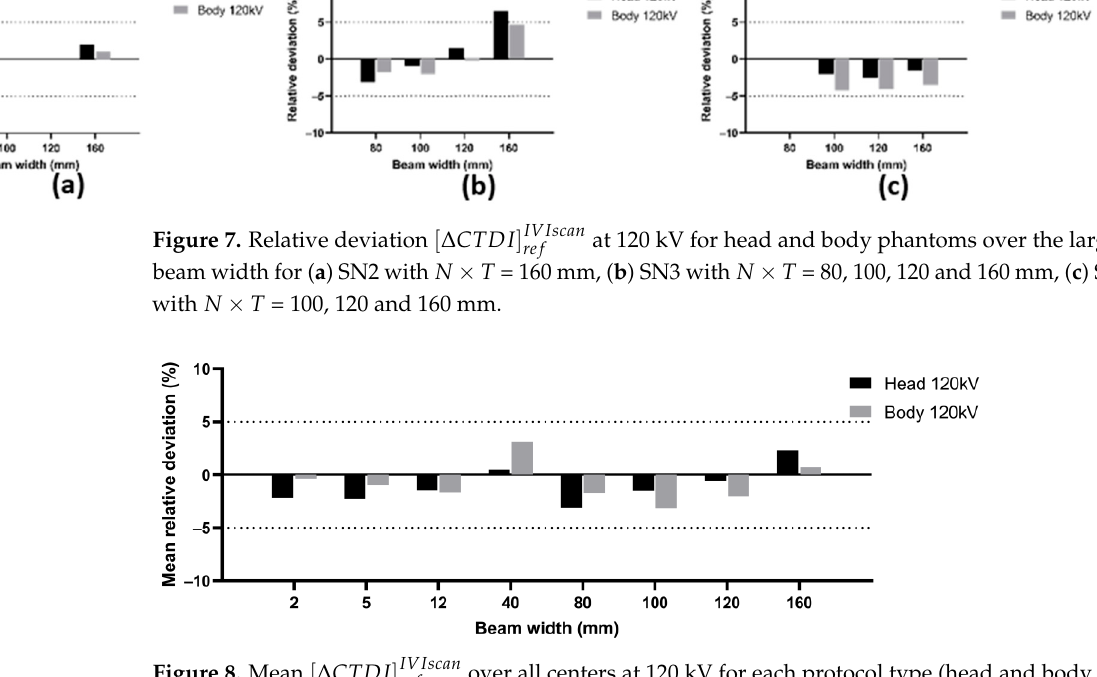
Figure 8. Mean [ ∆ CTDI ] IVIscan over all centers at 120 kV for each protocol type (head and body and Figure 8. Mean [∆𝐶𝑇𝐷𝐼] 𝑟𝑒𝑓𝐼𝑉𝐼𝑠𝑐𝑎𝑛 over all centers at 120 kV for each protocol type (head and body and ref beam width from 2 mm to 160 beam width from 2 mm to 160 mm).